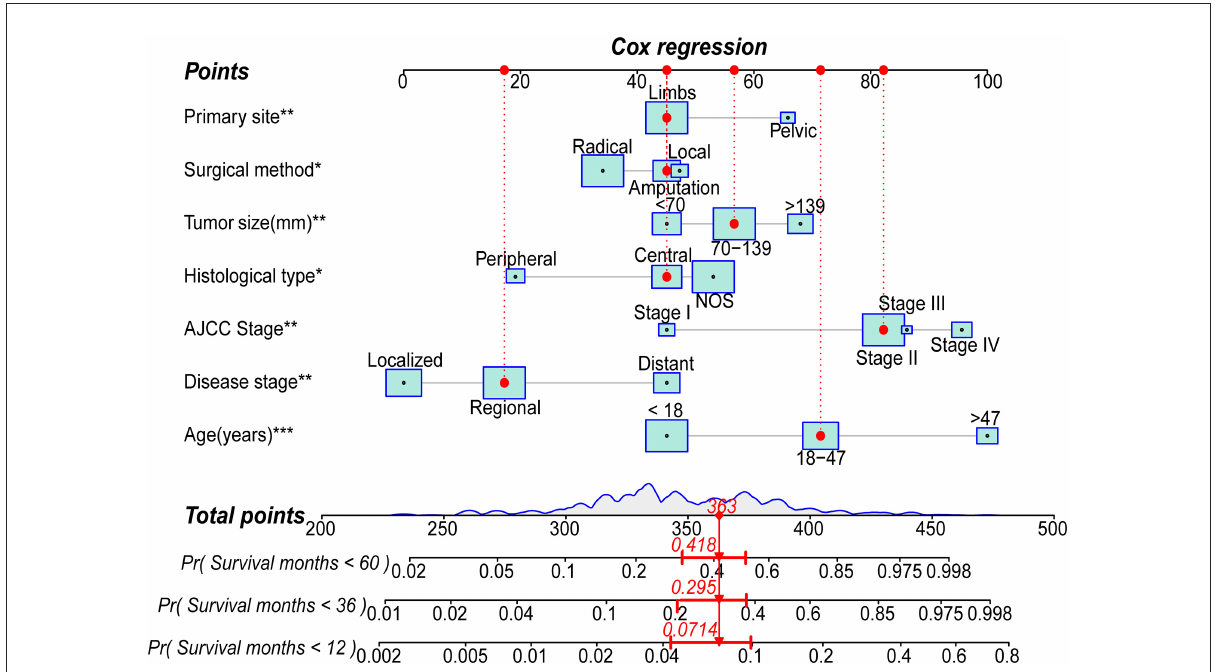
FIGURE2 Nomogram for predicting the 1-,3- and 5-year overall survival (OS) rates of patients with primary osteosarcoma after surgical resection ( *** P < 0.01; ** P < 0.01; * P < 0.05; Radical, Radical resection; Local, Local resection; Central, Central osteosarcoma; Peripheral, Peripheral osteosarcoma; NOS, Osteosarcoma,